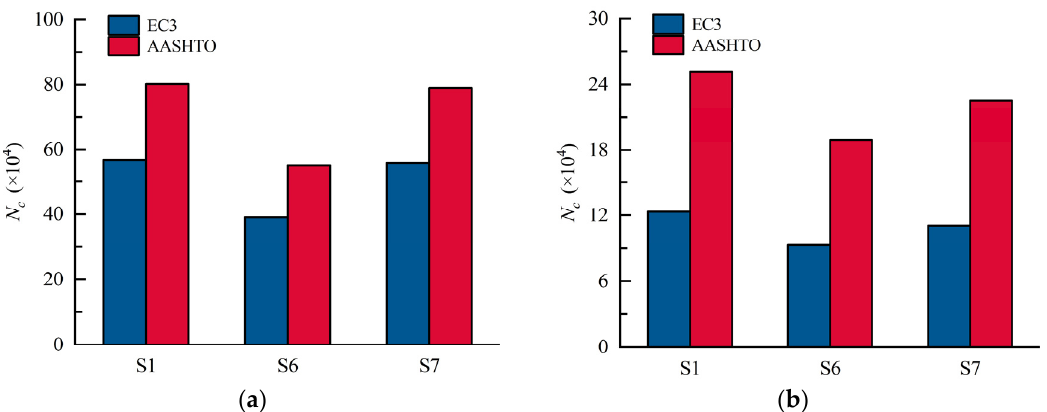
Figure 25. Fatigue lives of S1, S6, and S7 in different codes: ( a ) detail 2; ( b ) detail 4.